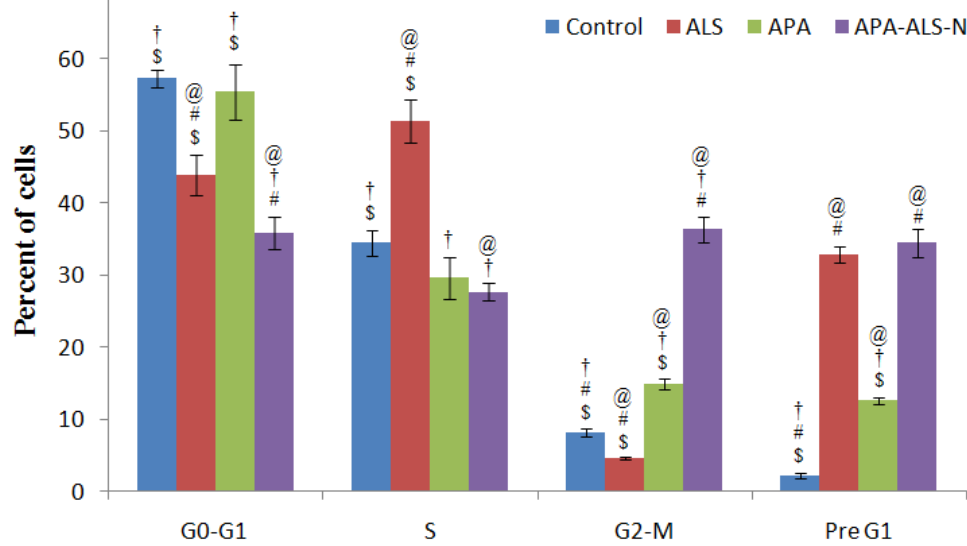
Figure 4. Cell cycle analysis results after treatment with control, ALS, APA, and APA-ALS-NC samples on PANC-1 cells. (Statistical inferences: @ p < 0.05, in comparison to control; † p < 0.05, in comparison to ALS; # p < 0.05, in comparison to APA; $ p < 0.05, in comparison to